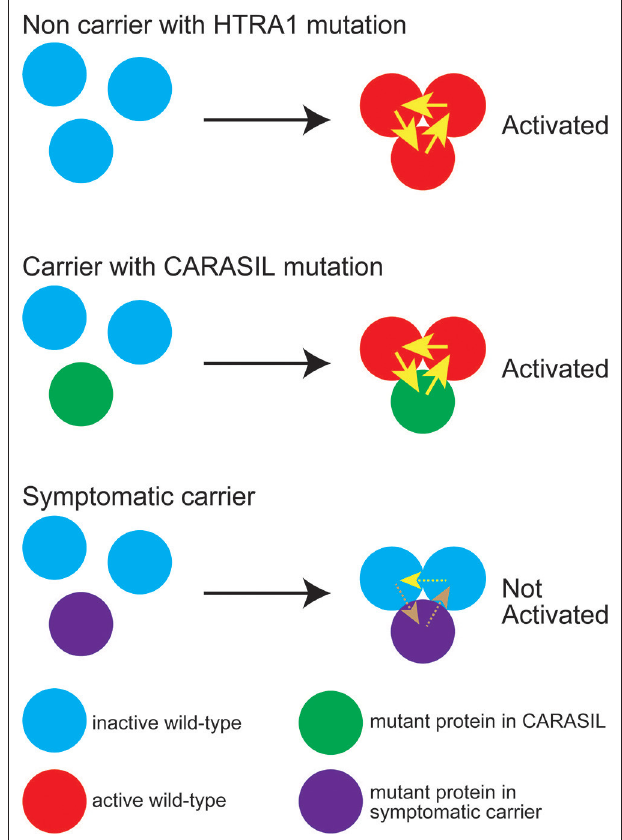
FIGURE 3 | Diagram representing HTRA1 protein activation status. The wild-type (WT) HTRA1 protein physiologically forms a trimer and activates the neighborhood HTRA1 protein through LD and the L3 domain (upper panel). Yellow arrows indicate activation of the neighboring HTRA1s through LD and the L3 domain. In carriers with CARASIL mutations, WT HTRA1, and mutant HTRA1 form a trimer and activate neighboring WT HTRA1 (middle panel). In symptomatic carriers, mutant HTRA1 interferes with the activation cascade of the trimer, which results in decreased WT HTRA1 protease activity (lower panel). Brown dashed arrows indicate failed activation of neighboring HTRA1s. It is still remained unknown whether WT protein can activate neighboring WT protein even in the trimeric state with dominant-negative mutant protein (yellow dashed